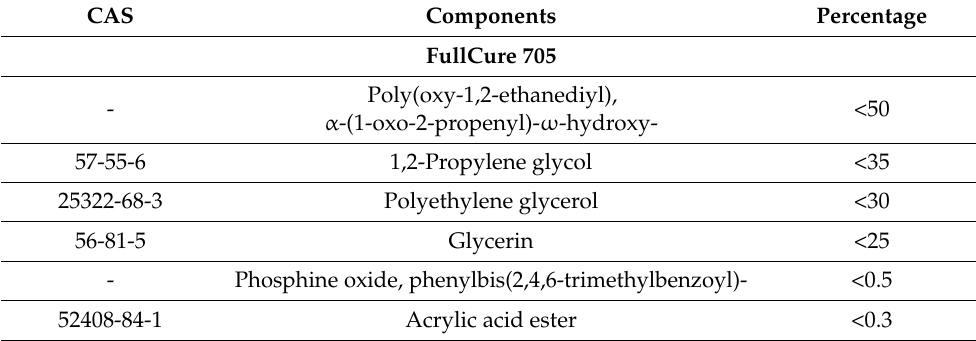
Table 3. Chemical composition of FullCure 705